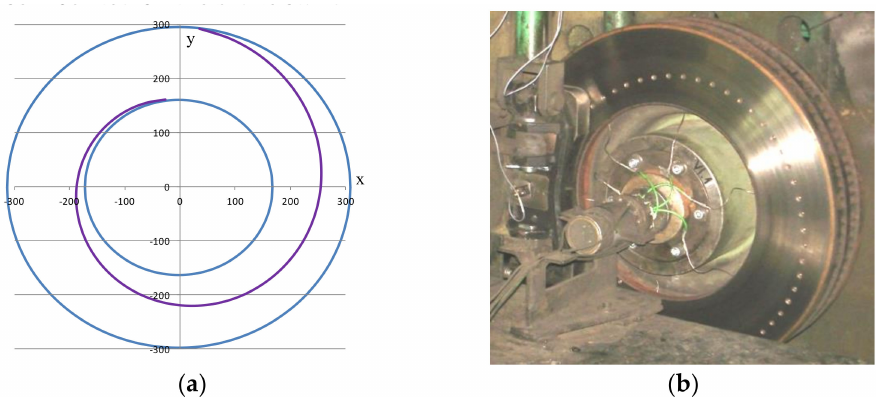
Figure 2. View of the brake disc: ( a ) diagram of the Archimedes spiral with one turn limited by the functions of a circle, ( b ) disc on the brake bench.